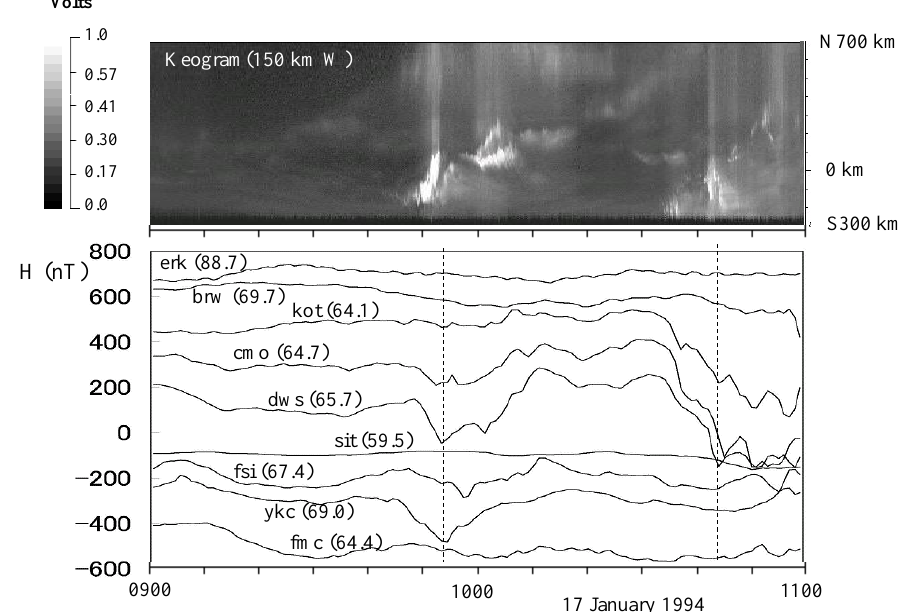
Figure 1. From top to bottom: 2-hour plots from 09:00 to 11:00UT for 17 January 1994, showing a keogram along geomagnetic meridians located 150km west of DWS (Keogram (150km W)) and the H component of the magnetic field in nT from eight stations in the auroral zone (BRW, KOT, CMO, DWS, SIT, FSI, YKC, FMC) and dawn-to-dusk component from the polar cap station (ERK). The vertical dotted lines indicate peaks of the negative bay of DWS at 09:53 and 10:42UT. The time resolution of the magnetogram is 1min. The aurora gray level is plotted to the left in volts, where three pieces of polygonal line conversion was used to make suppressions for high and low voltages.